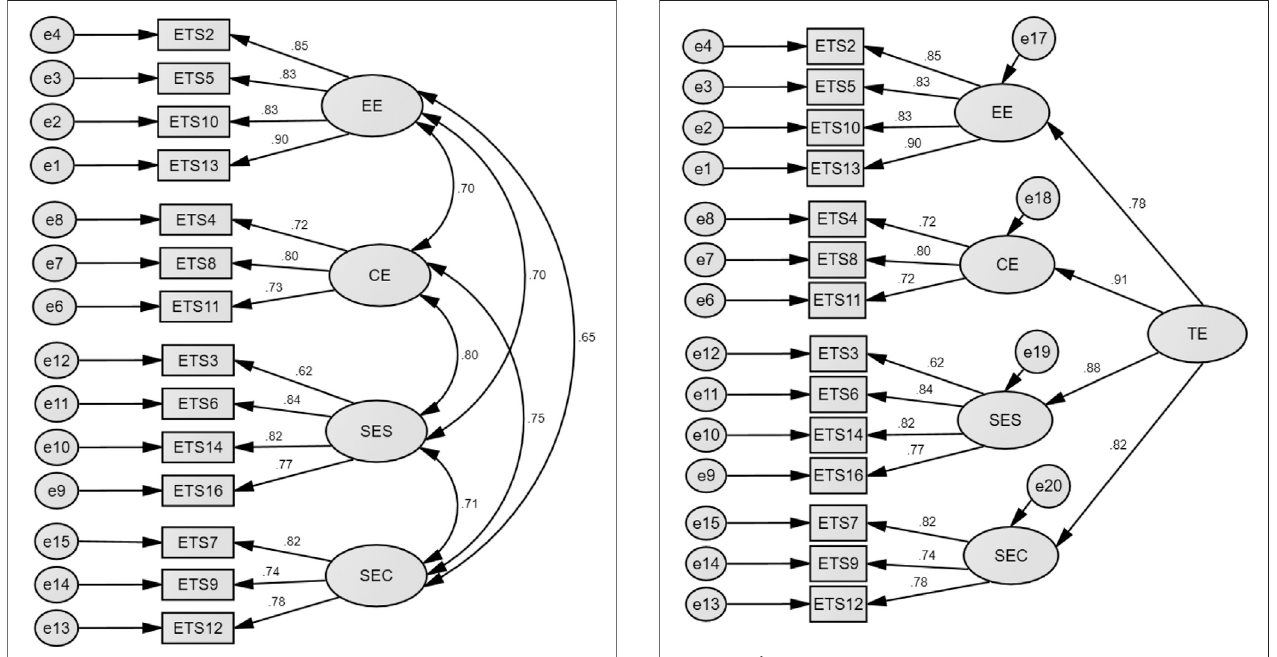
FIGURE 3 | Con fi rmatory factor analysis for the 14-item model of the C-ETS.